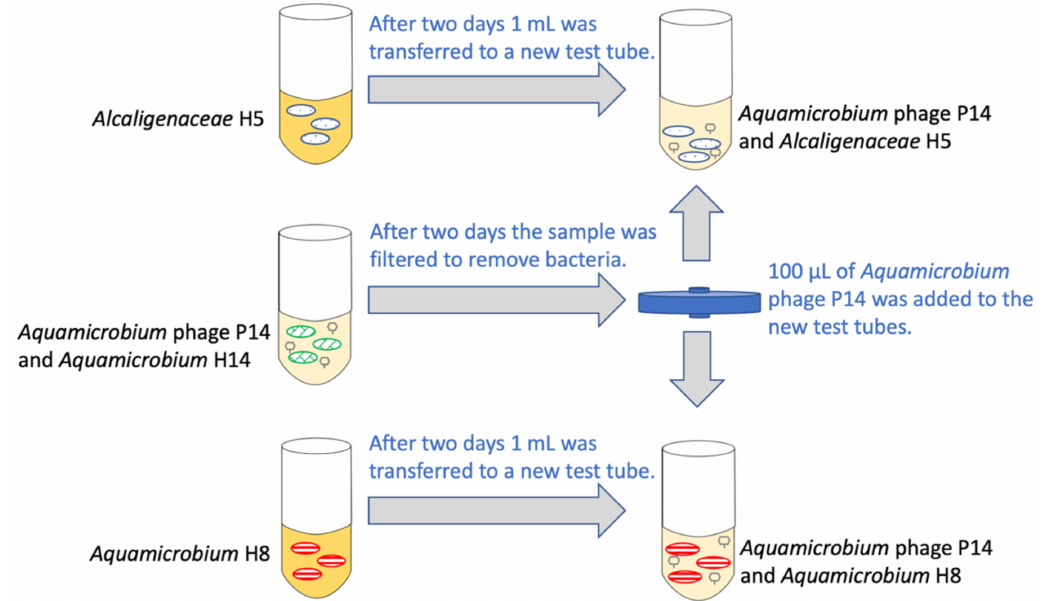
Figure 1. Schematic representation of the experimental